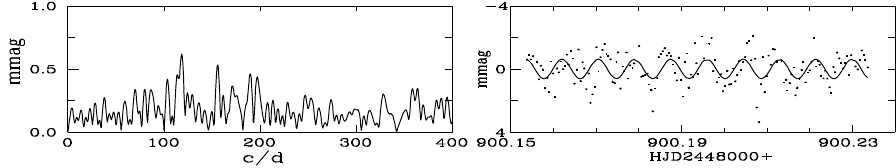
Fig. 2. At the left panel: the high frequency Fourier spectrum of the data of γ Equ on 4 Oct.1992. The semiamplitude of the peak at 118 c/d is 0.6 mmag and the noise is less than 0.3 mmag. At the right panel: a part of light curve with the fit of only this dominating